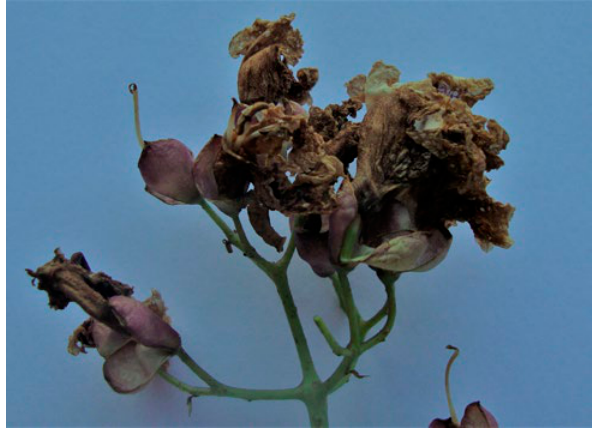
Figure 4. Chasmothecium of Erysiphe elevata with long